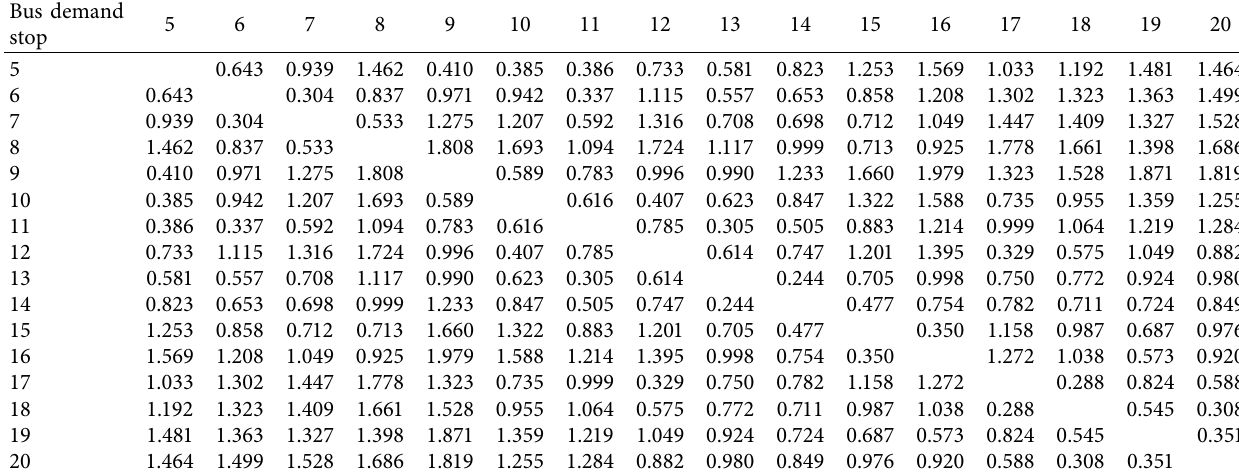
Figure 3: Topological relationship between metro stations and feeder bus stops along Fuzhou Metro line 2 (map date ⓒ 2022 Baidu.). Table 2: Length of paths between bus demand stops (unit: km).